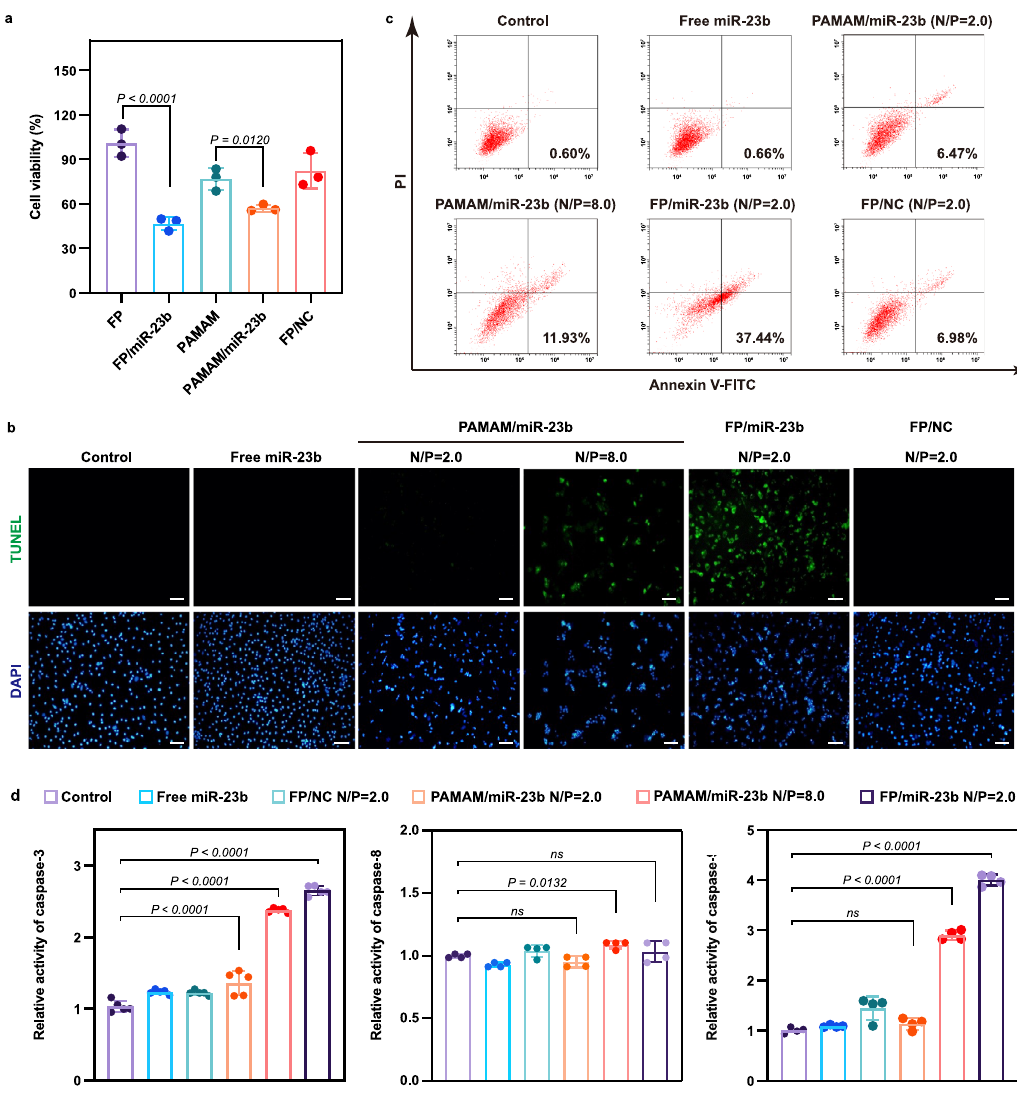
Fig. 3 | Inhibition of cell proliferation after miR-23b transfection in LPS- stimulated BMDMs. a The proliferative inhibition induced by the miR-23b trans- fection using MTT method. Data are presented as mean value±SD ( n =3 inde- pendent experiments). One-sided statistical analysis is measured by one-way ANOVA with LSD test. b The apoptosis effect induced by miR-23b delivery visua- lized by TUNEL staining. Nuclei, blue (DAPI); TUNEL, green. Scale bar: 50 μ m. A representative image of three biologically independent experiments from each groupisshown. c Thecellapoptosisanalysisusingthe fl